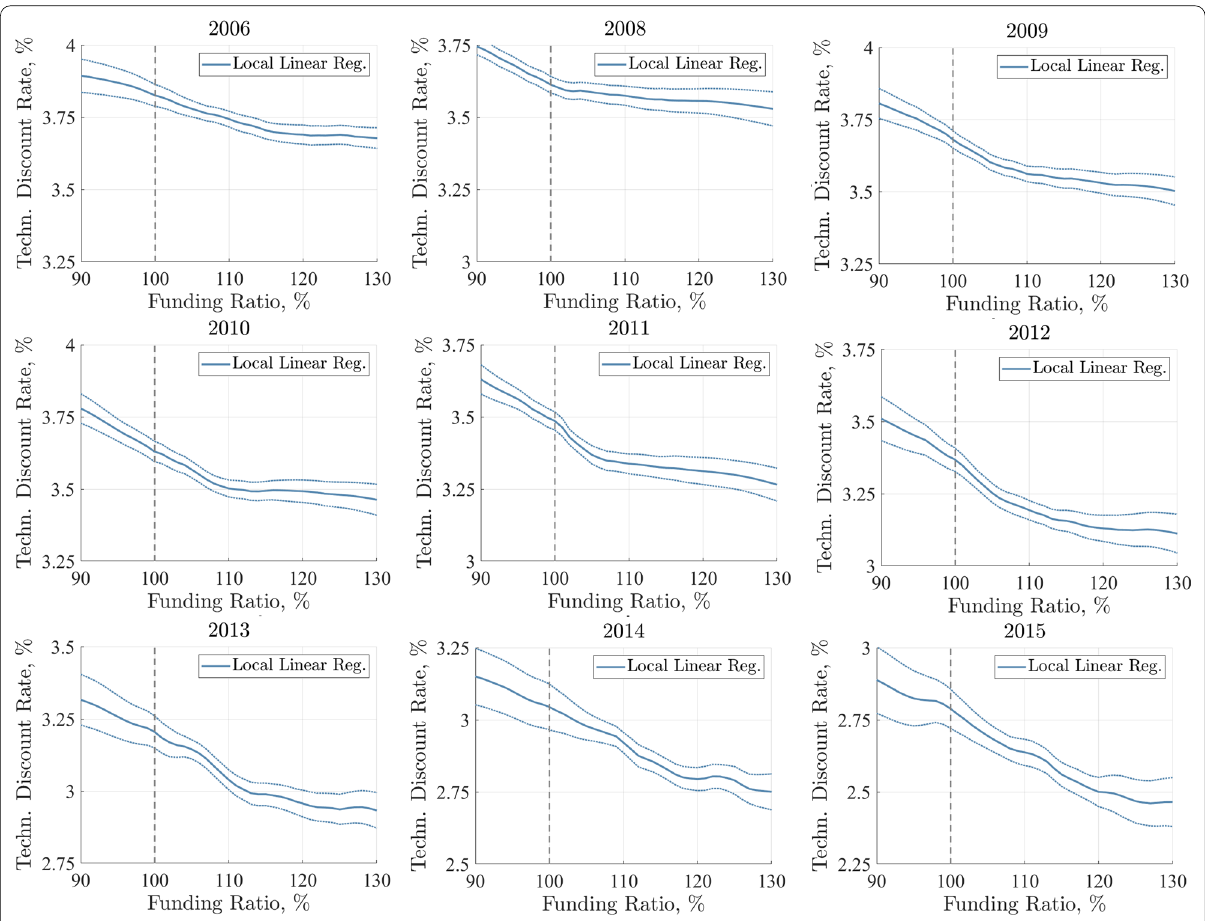
Fig. 10 Average Technical Discount Rate - Local Linear Regression. Figures show the weighted average discount rate (y-axis) used to discount pension liabilities of insurants, conditional on the funding ratio of the funds (x-axis). Blue solid lines are averages estimated by a local linear regression using a tricube kernel with varying bandwidths, considering the closest 20% of observations. Dotted blue lines show the 95% confidence band from bootstrapped standard errors (500 iterations). The average discount interest rate decreases the better a fund’s funding ratio. The sample includes only private and public funds without state guarantees, and only includes funds with a funding ratio between 81.5 and 152.3% (0.5th–95th percentile range). Years, 2007, 2016, and 2017 in the main